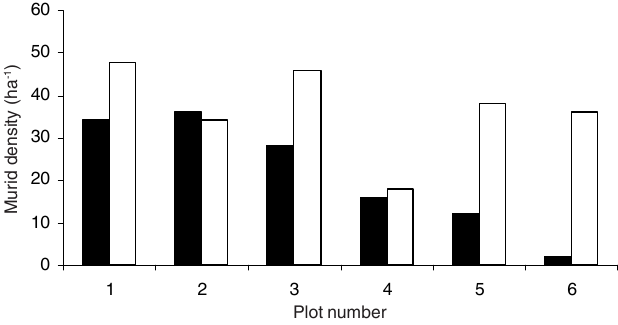
Figure 2. Densities of murids in the six study plots in the Kanneliya rainforest before (soild bars) and after (open